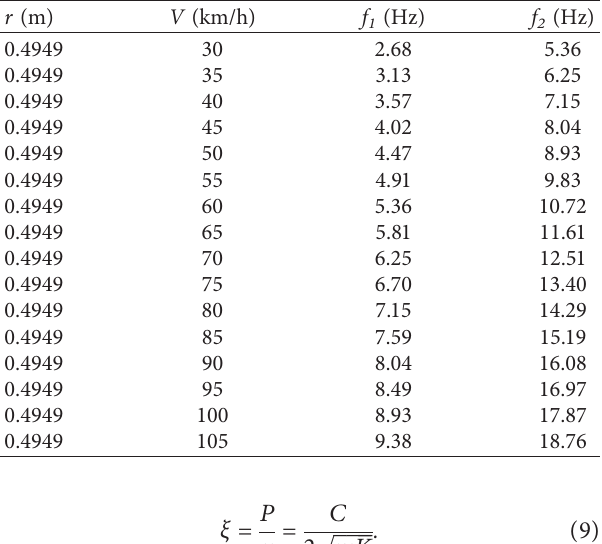
Table 1: Wheel rotation frequency at each